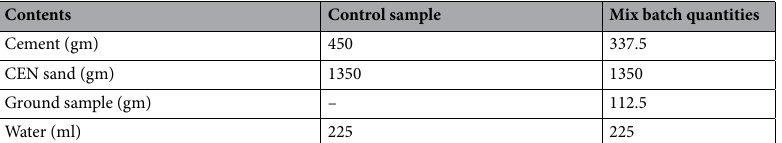
Table 3. Amounts of materials required to prepare mixture batches for the determination of pozzolanic activity according to EN 196-1/2011 that comply to TS